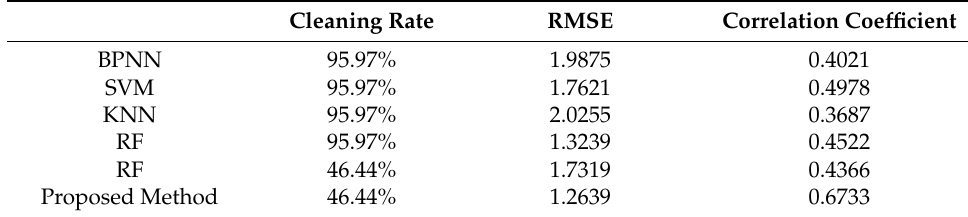
Table 4. Results of different